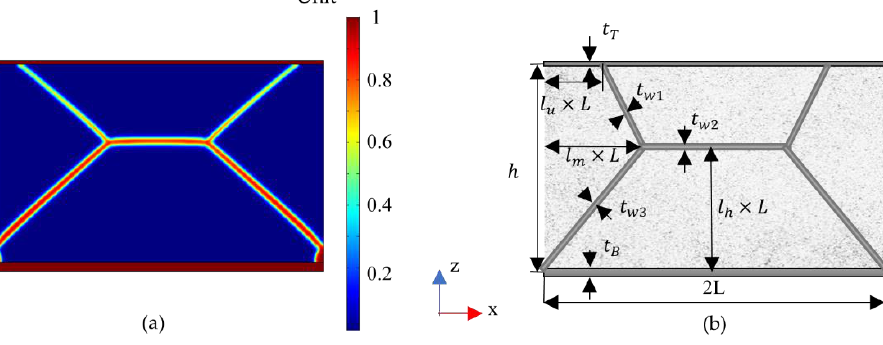
Figure 9. ( a ) 2D topology optimization result under coupled loads; ( b ) reconstructed model. Table 5. Parameters of reconstructed ITPS panels. Table 5. Parameters of reconstructed ITPS panels.